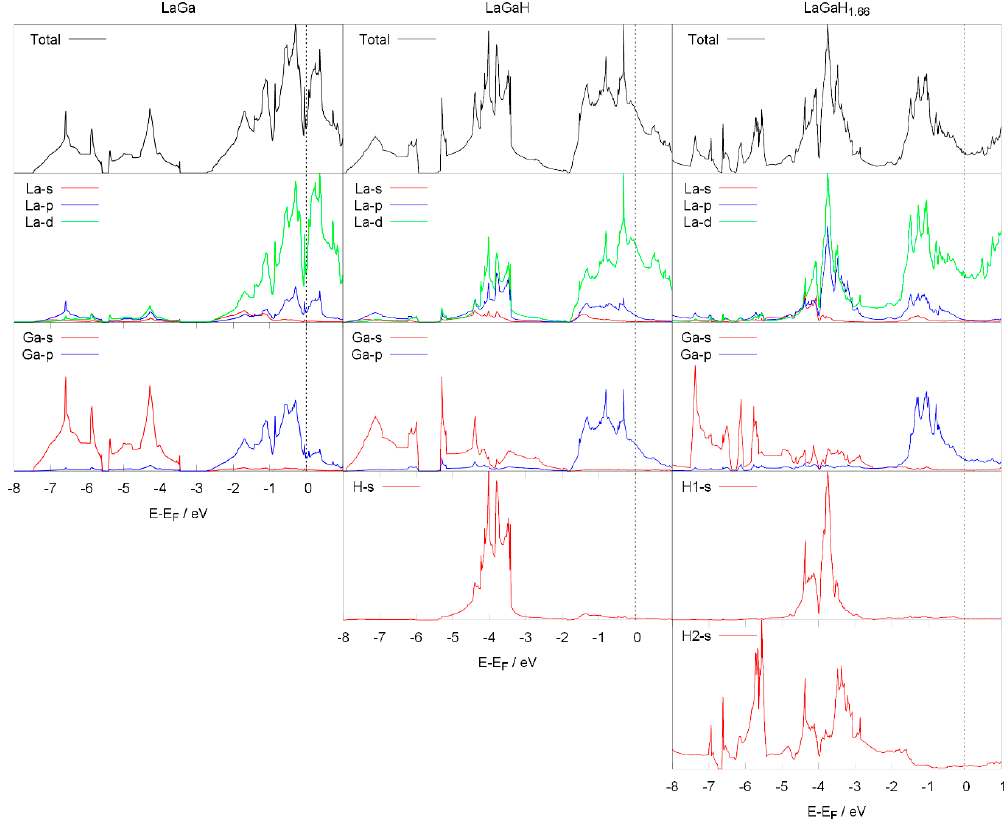
Figure 6. Calculated density of states of LaGa ( left ), LaGaH ( middle ), and LaGaH 1.66 ( right ) with black dotted lines indicating the Fermi level.